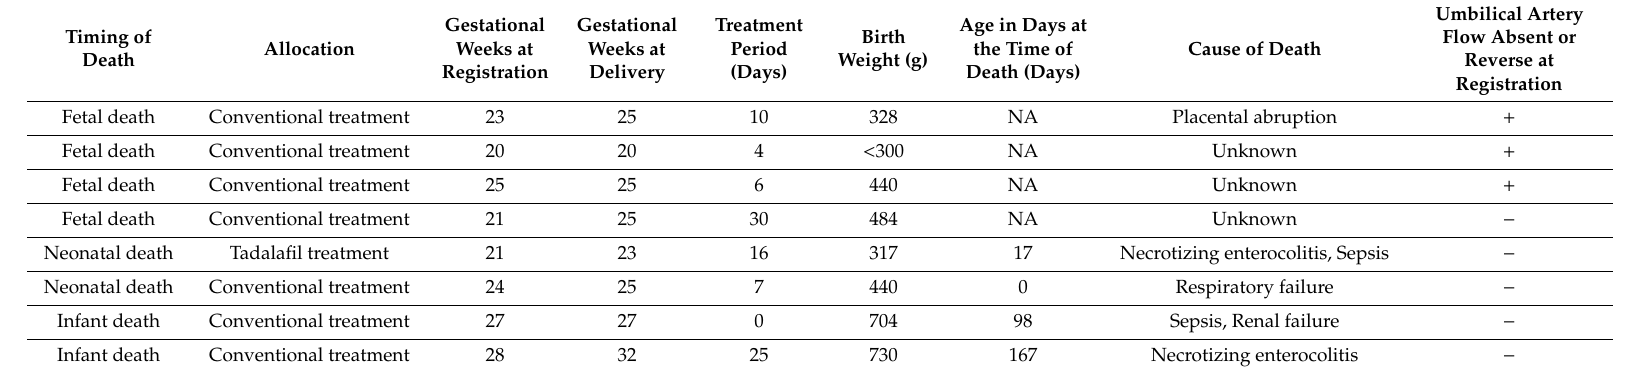
Table 4. Details of fetal, neonatal, and infant death